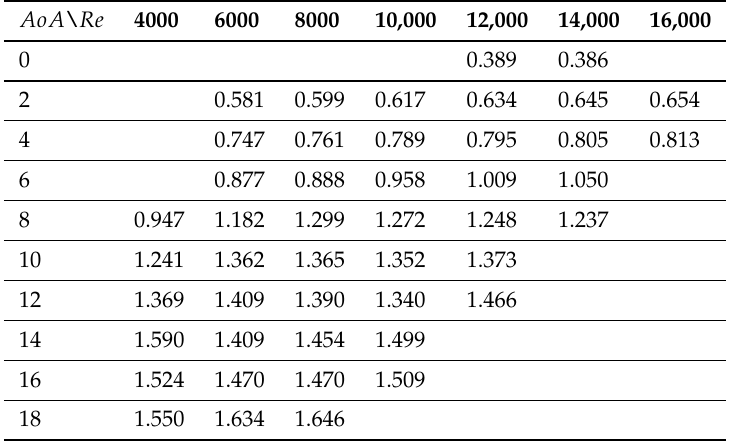
Table 8. Lift coefficient C L for the Reynolds numbers Re and the angles of attack AoA experienced by the blade sections for the tip-speed ratios around the optimal one.